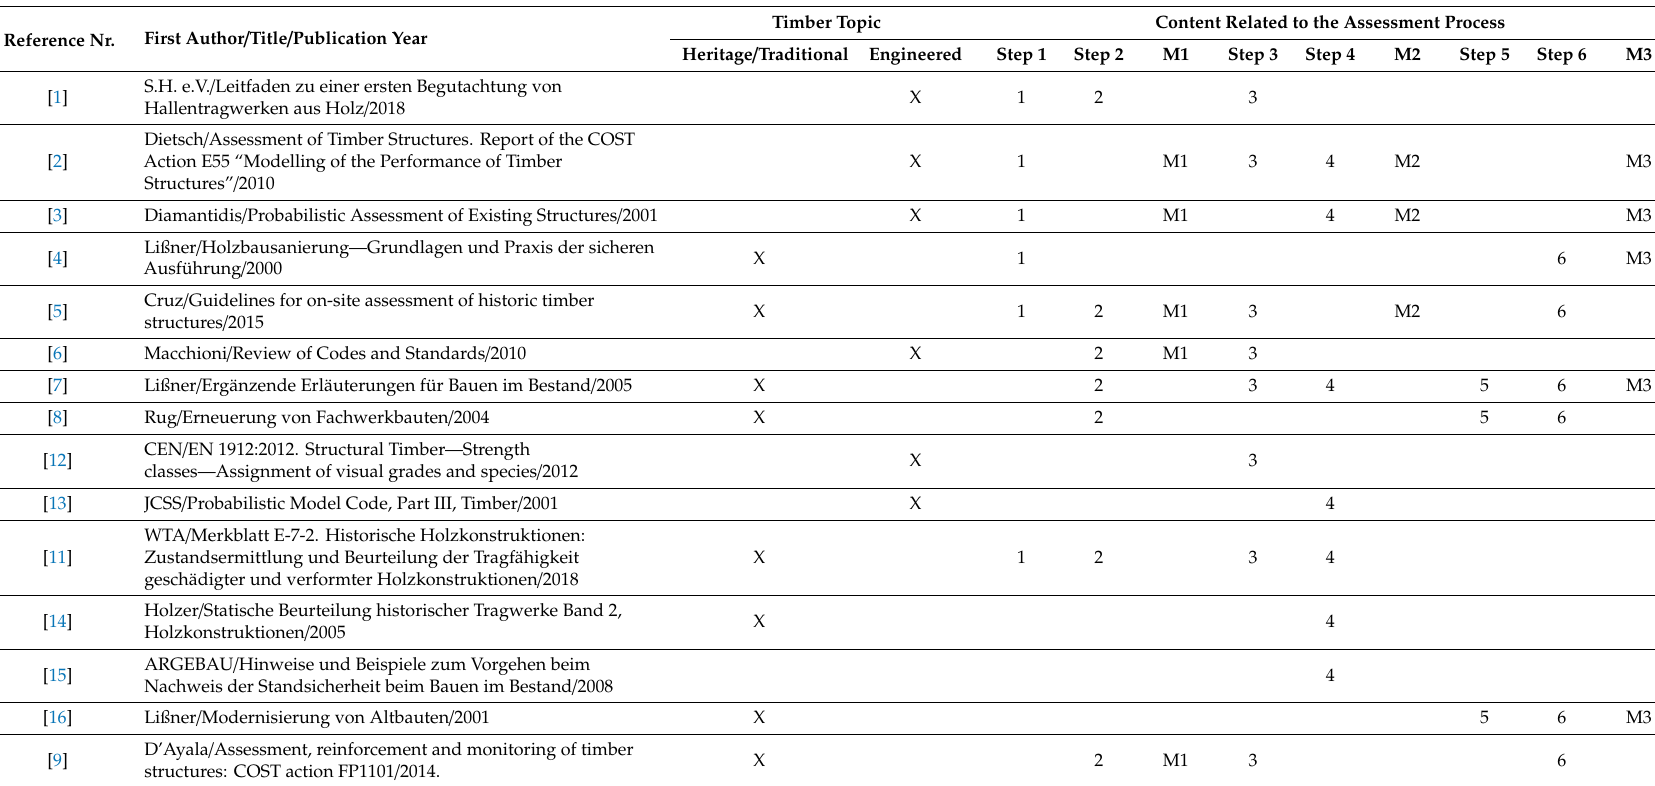
Table 1. Content of selected papers. Each paper is reviewed considering the identified steps (S) and milestones (M) according to the Six-steps assessment process of Figure 1. For each paper, the discussed contents are reported. Reference